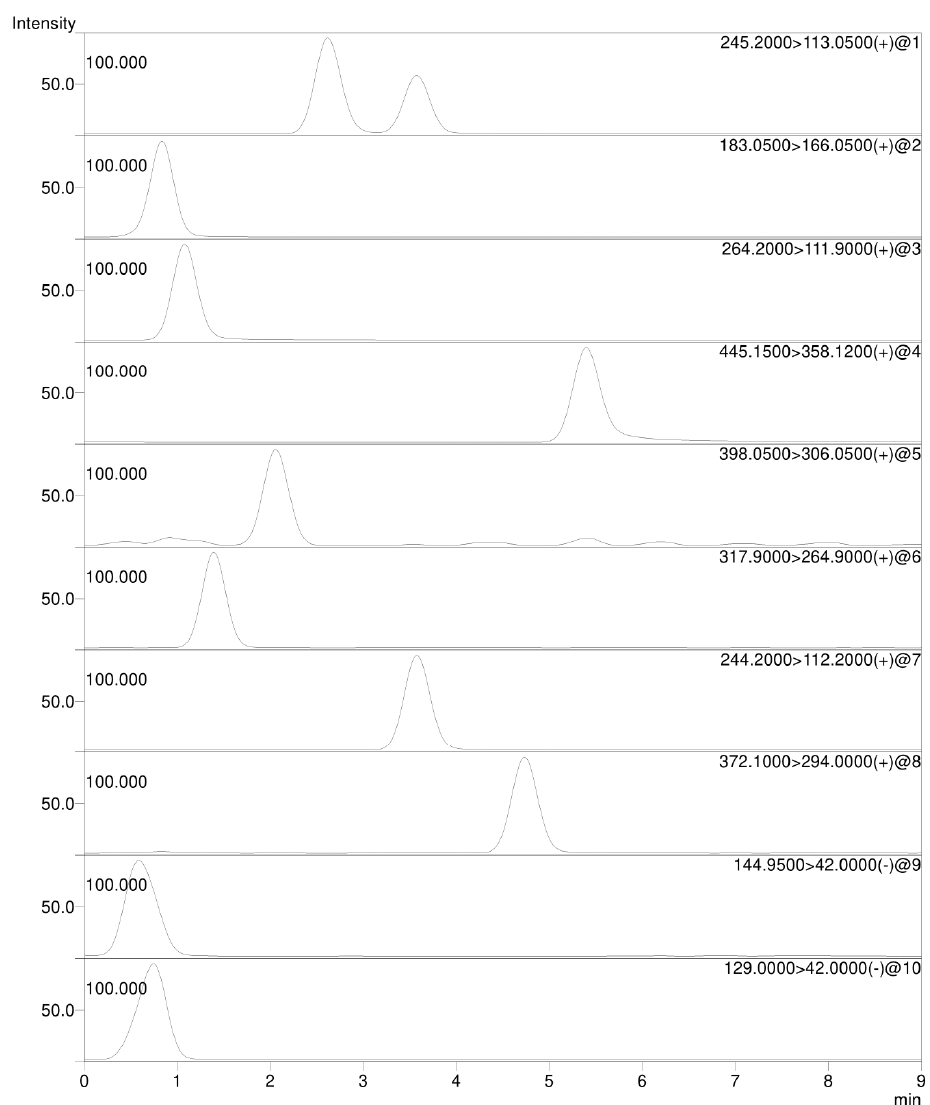
Figure 1. Stacked view of the experimental chromatogram. LEGEND: 1, 5-azacytidine; 2, dacarbazine; 3, gemcitabine; 4, mitoxantrone; 5, oxaliplatin; 6, cisplatin; 7, cytarabine; 8, carboplatin; 9, 5-chlorouracil; 10, 5-fluorouracil. The values of retention time, peak width, theoretical plates number, and retention factor are reported in Table